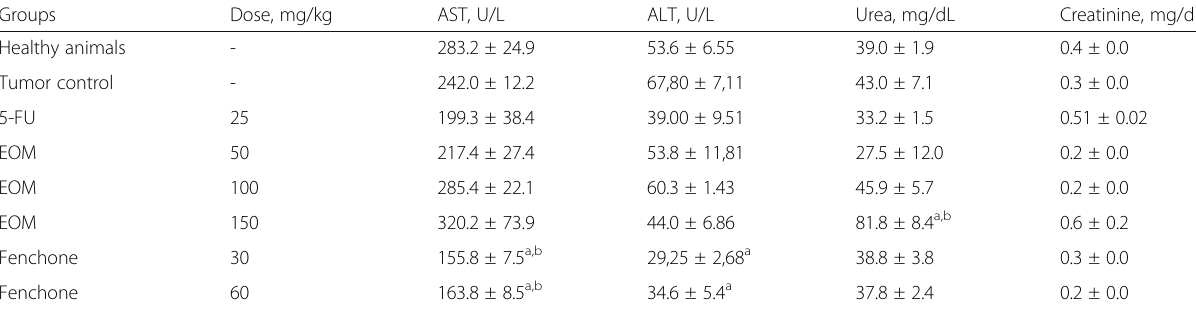
Table 7 Effects of EOM, fenchone and 5-FU on biochemical parameters of peripheral blood of mice ( n =6) subjected to different treatments (9